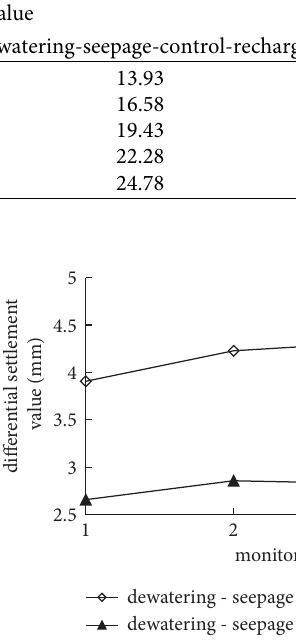
Figure 10: Diferential settlement curves for adjacent monitoring points under the two working conditions of dewatering-seepage control and dewatering-seepage control-recharge. Note: abscissa 1 is the settlement diference between A1 and A2; 2 is the settlement diference between A2 and A3; 3 is the settlement diference be- tween A3 and A4; 4 is the settlement diference between A4 and